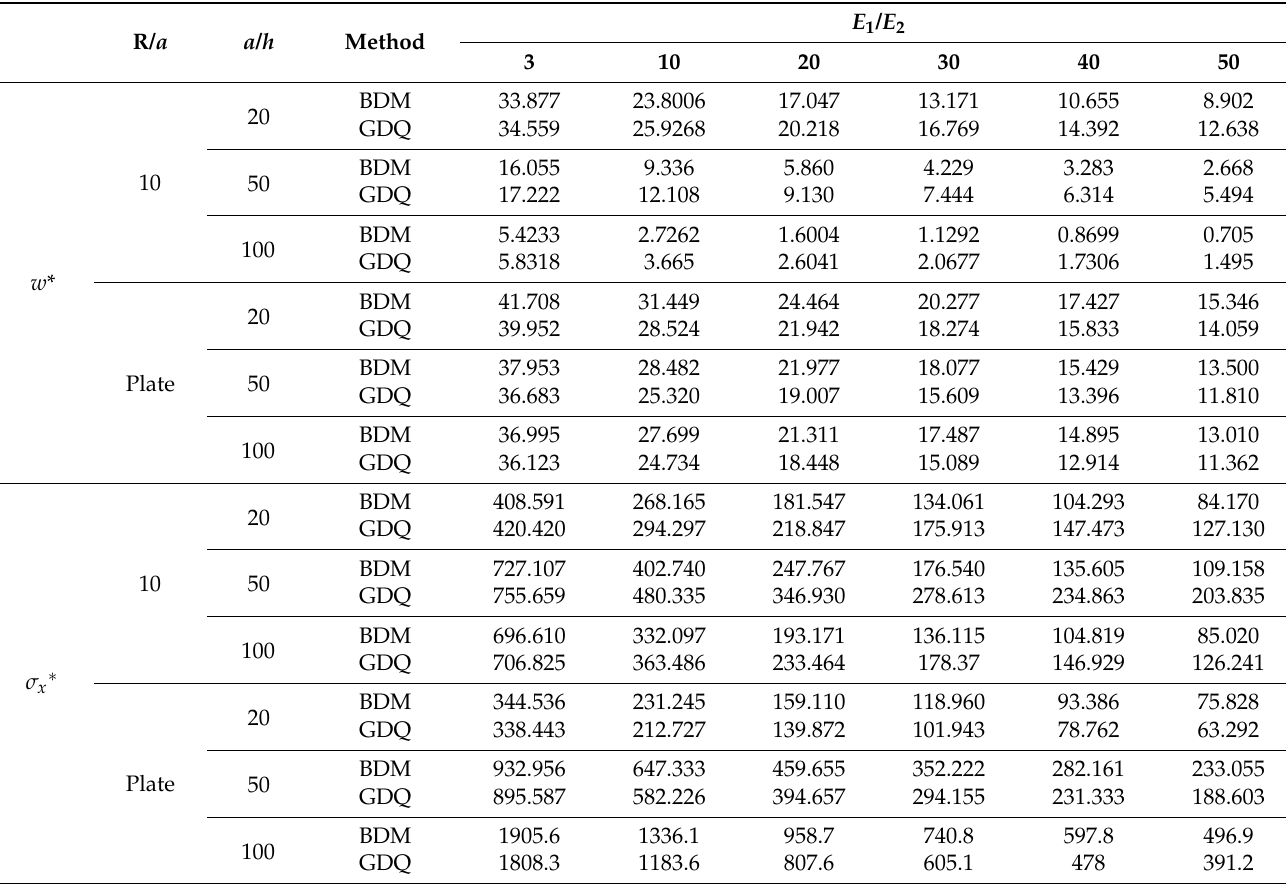
Table 4. Normalized central deflections of cross-ply [0 ◦ /90 ◦ ] laminated shells under uniform